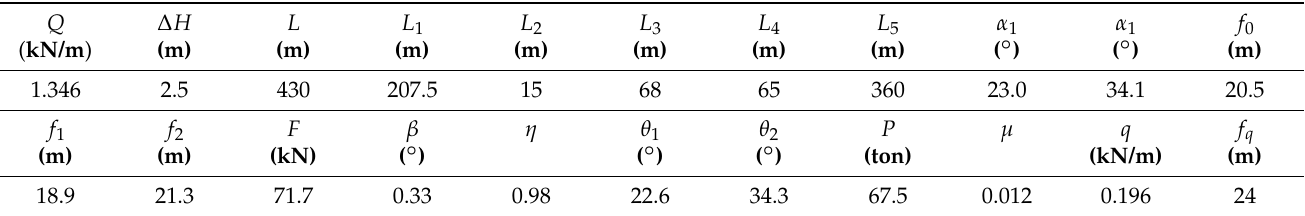
Table 1. Parameters of the cable system when carrying to